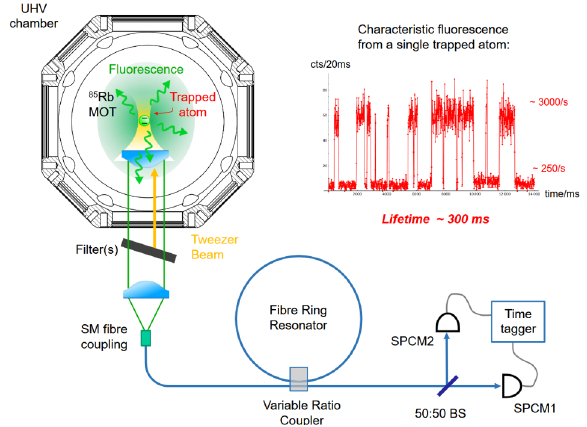
Figure 1. Schematic of out experimental setup. We trap a sin- gle 85 Rb atom inside an optical dipole trap and collect its flu- orescence using a high NA microscope. The collected light is subject to a narrow-band band-block filter that is realized using a fiber-based ring resonator with a variable coupler. Depending on the incoupling rate, we can change the photon statistics of the collected atomic fluorescence from anti-bunching to strong pho- ton bunching which we measure using a Hanbury-Brown Twiss setup. Inset: Time trace of the atomic fluorescence measured without